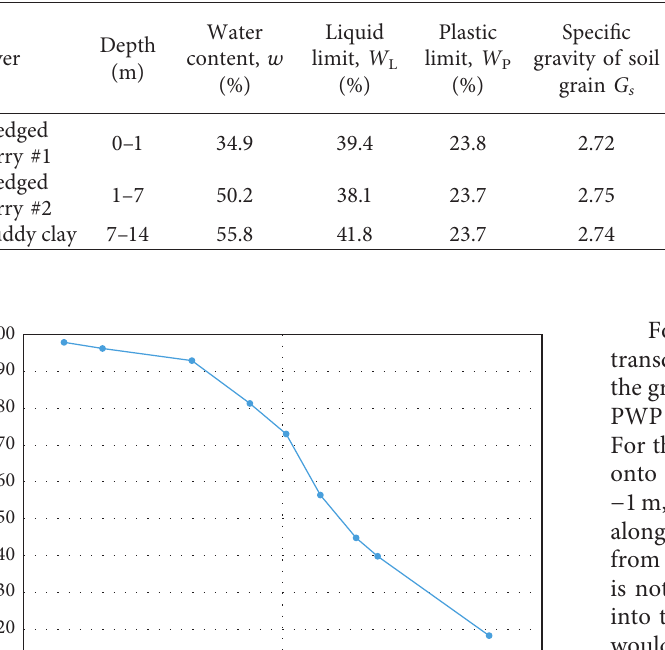
Table 1: Physical properties of different soil layers at the test site.